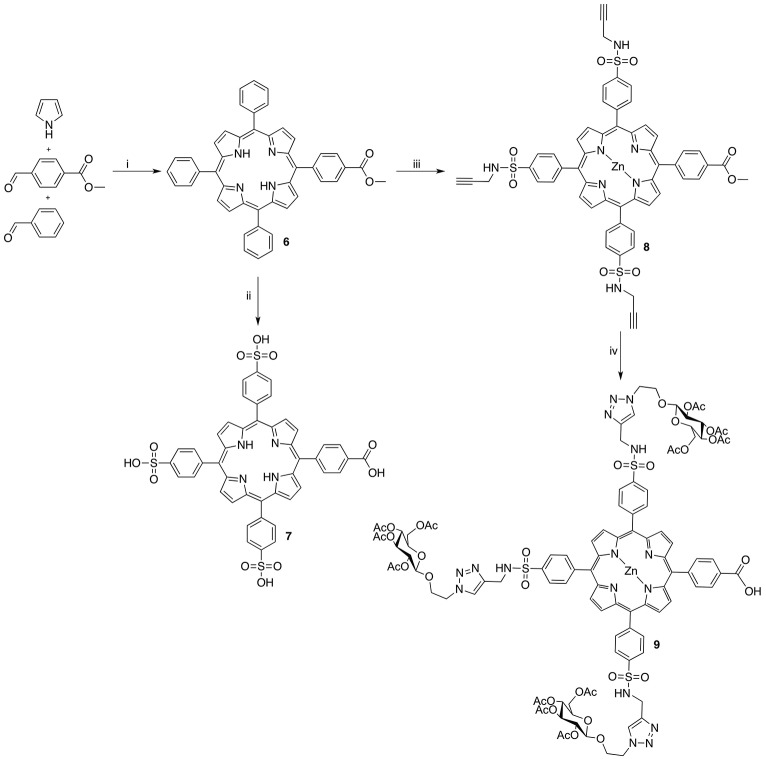
Reagents and conditions: (i) 1. BF3•OEt2, NaCl, DCM, r.t. 2. DDQ, r.t. 3. TEA, r.t. 19% (ii) 1. HSO3Cl, r.t. 2. H2O, 80°C; 3. NaOH, r.t., quant. (iii) 1. HSO3Cl, r.t. 2. Propargylamine, DIPEA, DMF, r.t. 3. Zn(OAc)2(H2O)2, DCM, MeOH, r.t., 40% over 2 steps; (iv) 1. LiCl, DFM, MW, 160°C, 77%. 2. Acetylated azidoethyl glucoside, CuSO4, sodium L(+)-ascorbate, THF, t-BuOH, H2O, MW, 85°C, 59%.